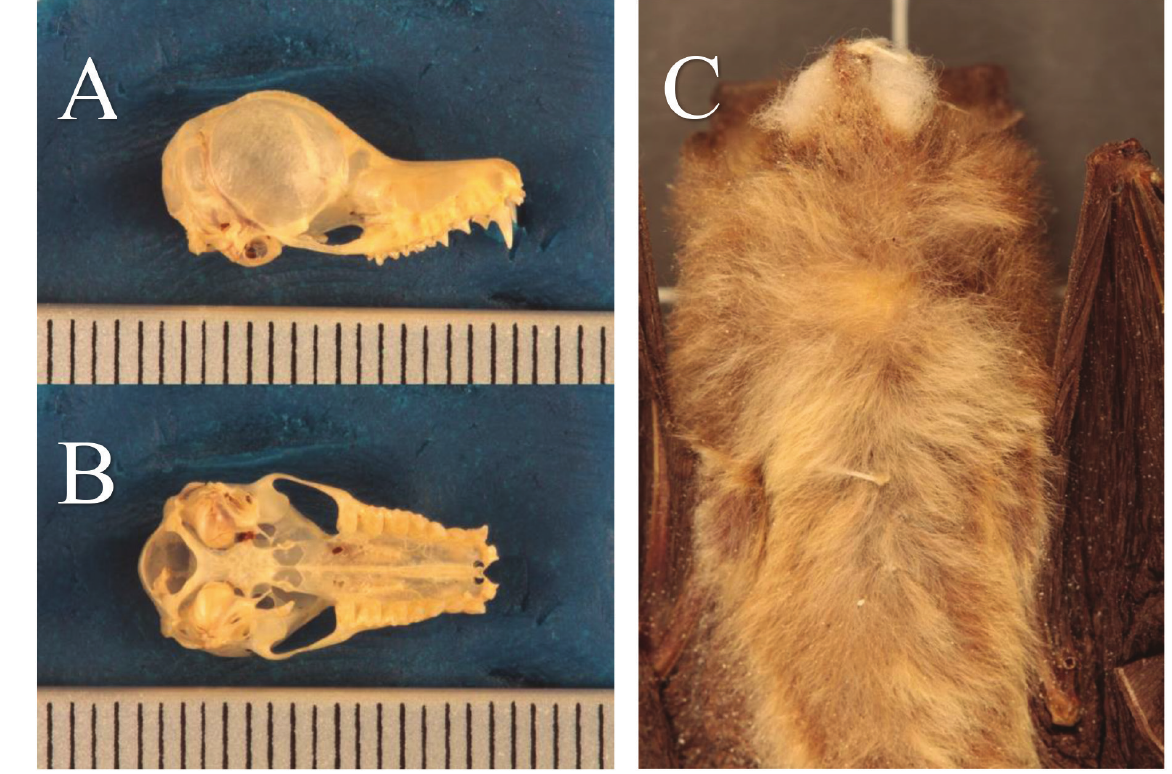
Figure 4. A Lateral and B ventral views of the skull of Natalus lanatus (TCWC 10992) captured in Zamorano in department of Francisco Morazán, August 1963. C Bicolor ventral pelage of N. lanatus of the same